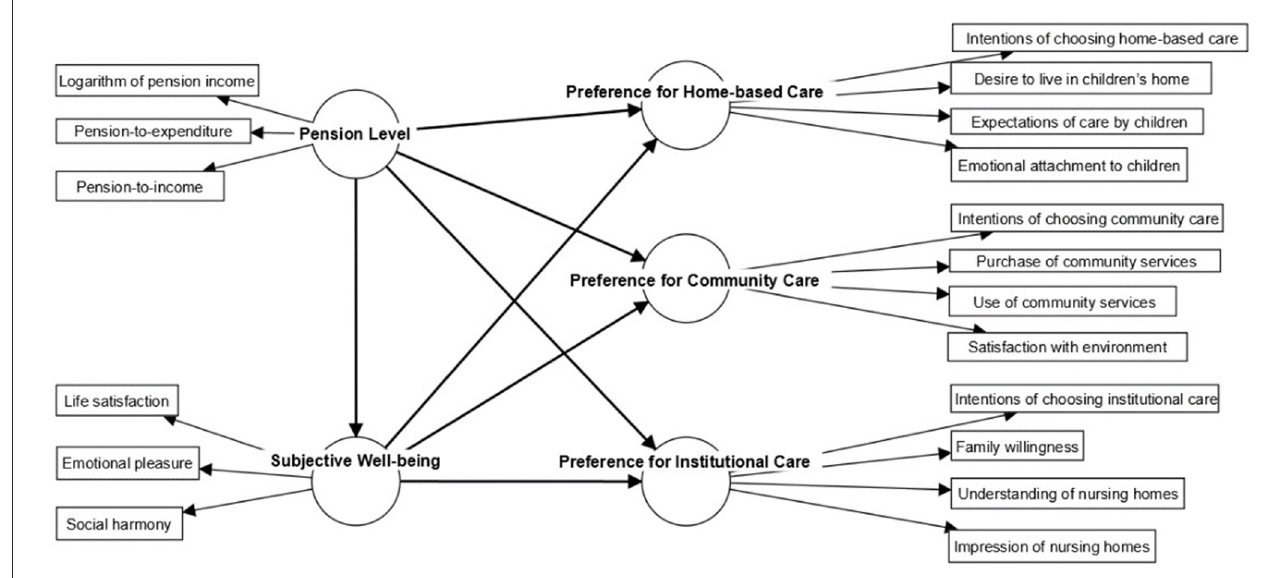
FIGURE1 Research